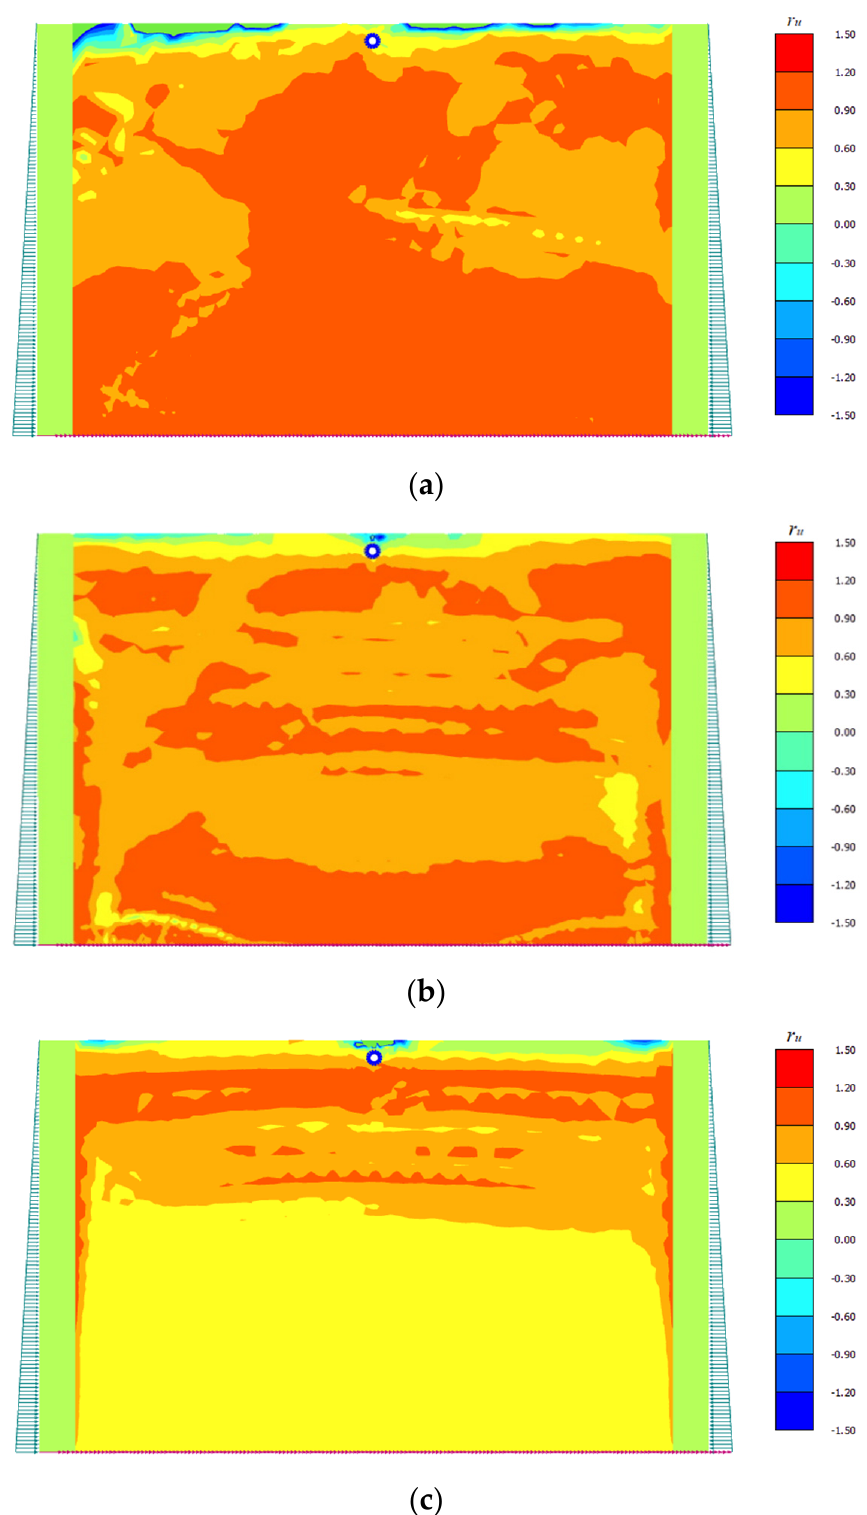
Figure 4. Liquefaction potential of soil with 50% relative density and a seismic signal of 0.1 g amplitude and ( a ) 1 Hz, ( b ) 2 Hz, and ( c ) 3 Hz frequency.